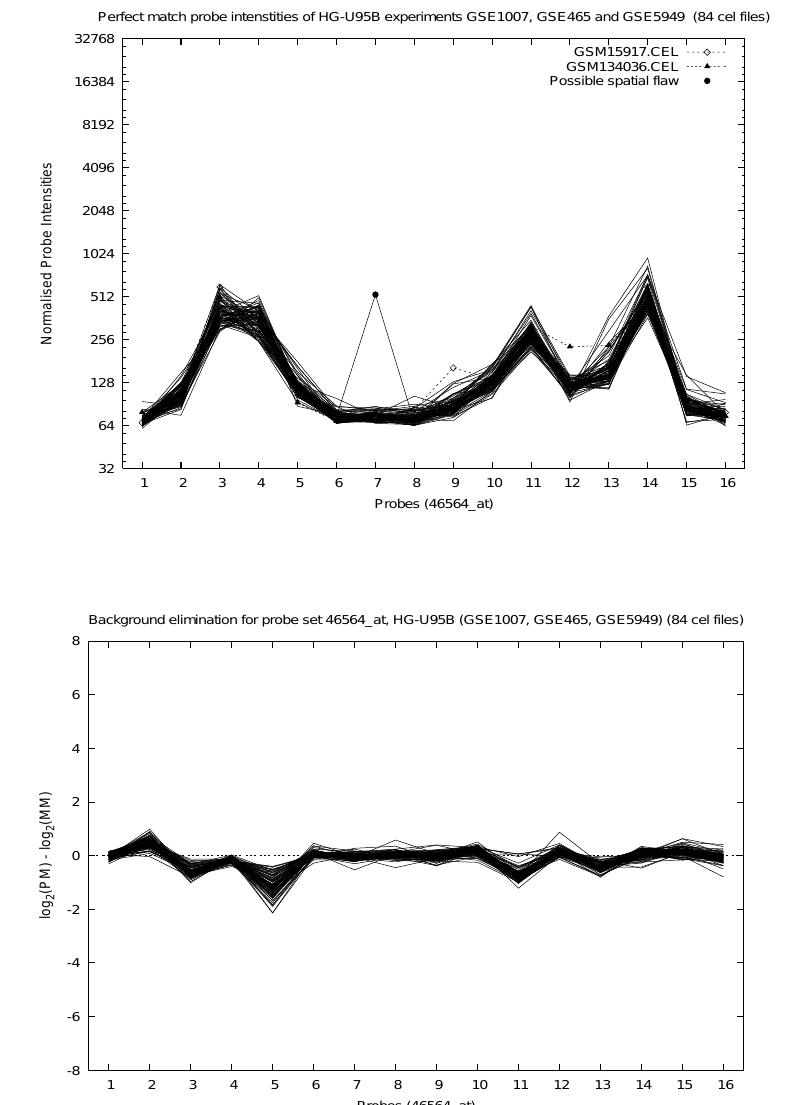
Figure 2: Probe intensities for experiments GSE1007, GSE465, GSE5949 of probe set 46564 at on the HG U95B array (A) Perfect match intensities (log scale) (B) Background elimination (log 2 (PM) - log 2